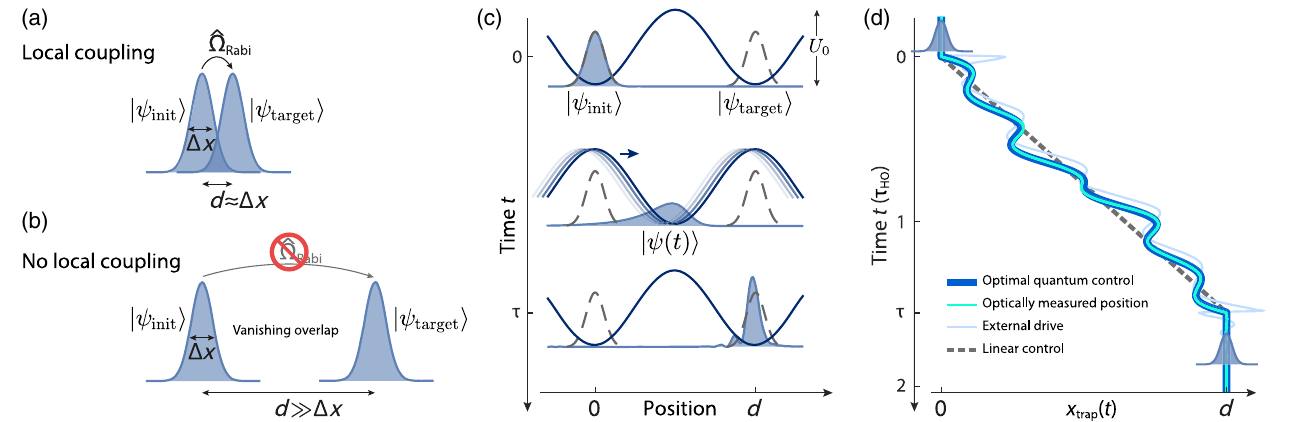
ˆ Ω FIG. 1. Transporting a massive quantum particle to a distant state. (a) Direct local coupling between the initial and target state Rabi can be realized when the two wave functions have nonzero spatial overlap. (b) Fundamentally, no direct local coupling between the two states can be realized for large separations, d ≫ Δ x , suppressing the possibility to attain the Mandelstam-Tamm bound. (c) Atom transport in an optical conveyor belt (sinusoidal potential curves), depicted at the initial, intermediate, and final time of the process. The probability distribution of the transported wave packet j ψ ð t Þi is shown (shaded area), together with that of the initial and target states (dashed lines). For illustration purposes, the chosen example shows a wave packet ending up in an excited state, corresponding to a low t Þ of the optical conveyor belt (dark blue), corresponding to the ( F ∼ 0 . 5 ) transport fidelity. (d) Quantum brachistochrone trajectory x trap ð diamond data point marked by an arrow in Fig. 2. The actual position of the conveyor belt (cyan), measured with 1 Å precision by optical interferometry, and the corresponding external drive (light blue), applied to steer the conveyor belt position, are also shown. For comparison, a linear transport ramp (dashed line) is